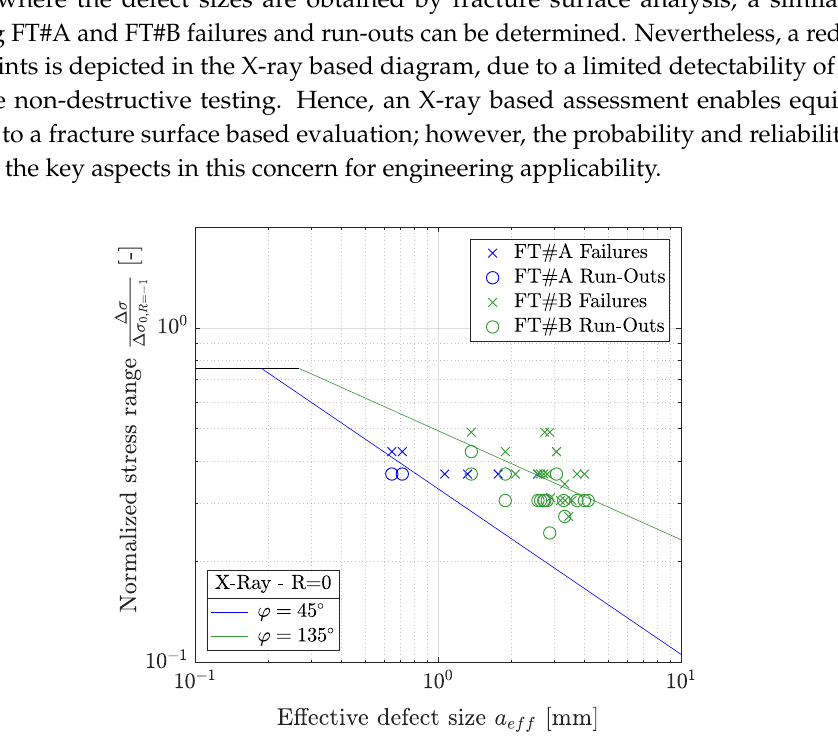
Figure 23. Generalized Kitagawa diagram at R = 0 stress ratio based on X-ray imperfection size evaluation